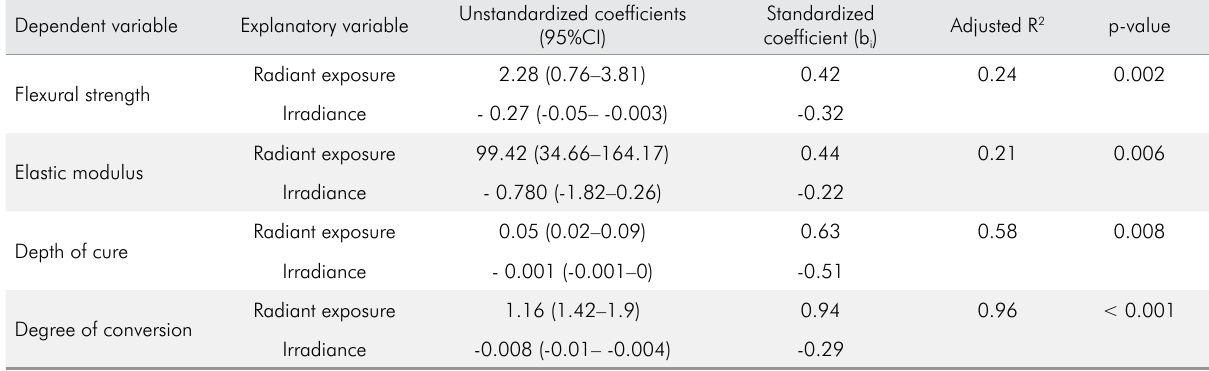
Table 2. Summary of the multiple linear regression